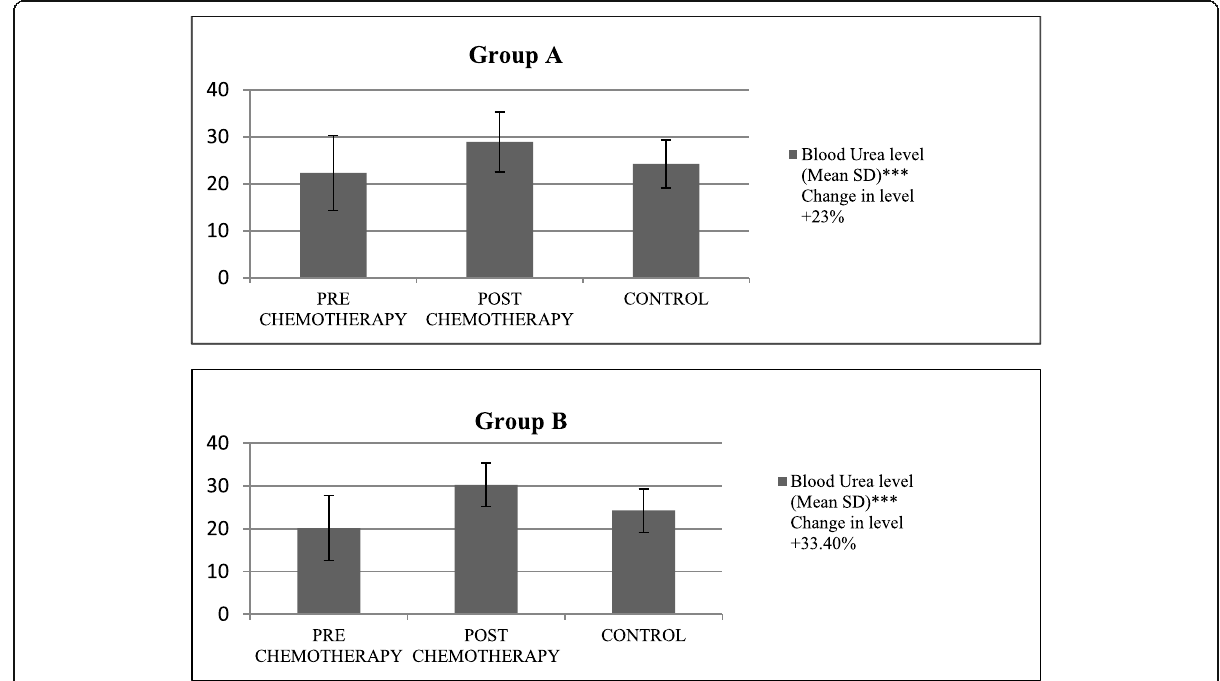
Fig. 1 Changes in blood urea level in both groups. *** p < .001 (extremely significant). Change in terms of increase in levels are indicated by plus